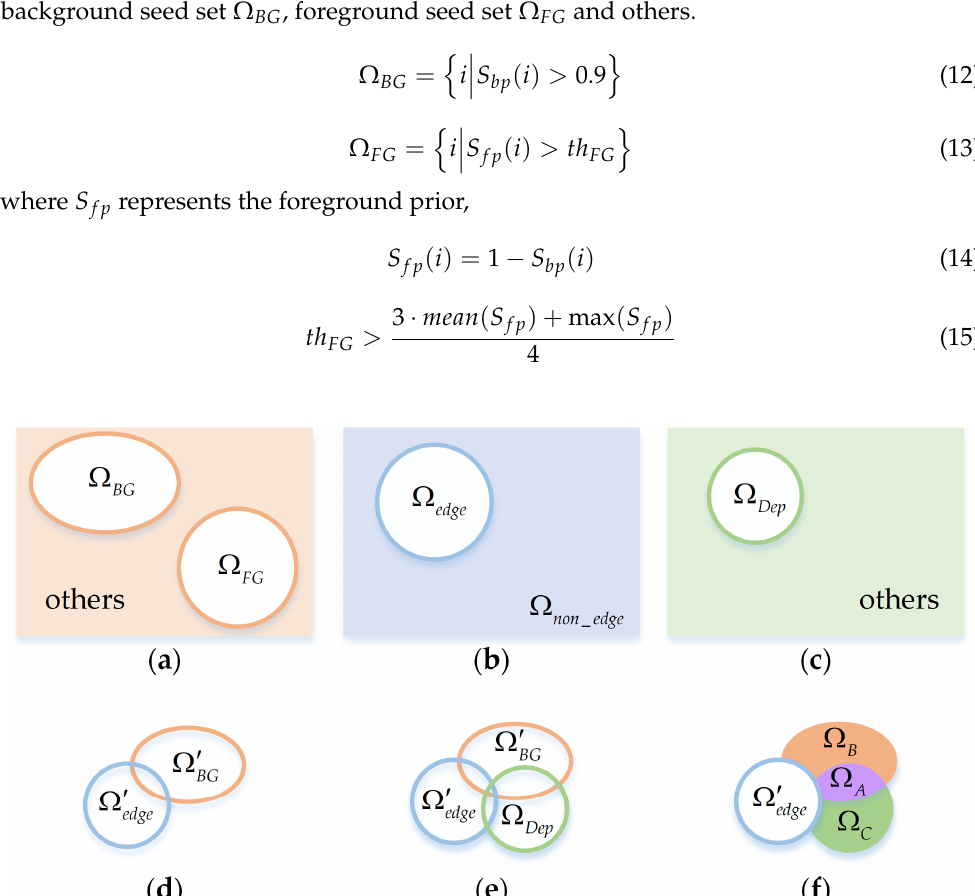
Figure 3. The process diagram of the background seed screening. ( a ) The node sets based on saliency attribute; ( b ) The node sets based on location attribute; ( c ) The node sets based on depth attribute; ( d ) The node sets after removing the foreground nodes; ( e ) The diagram of the comprehensive relationship between the three attributes; ( f ) The final node sets after classifying.